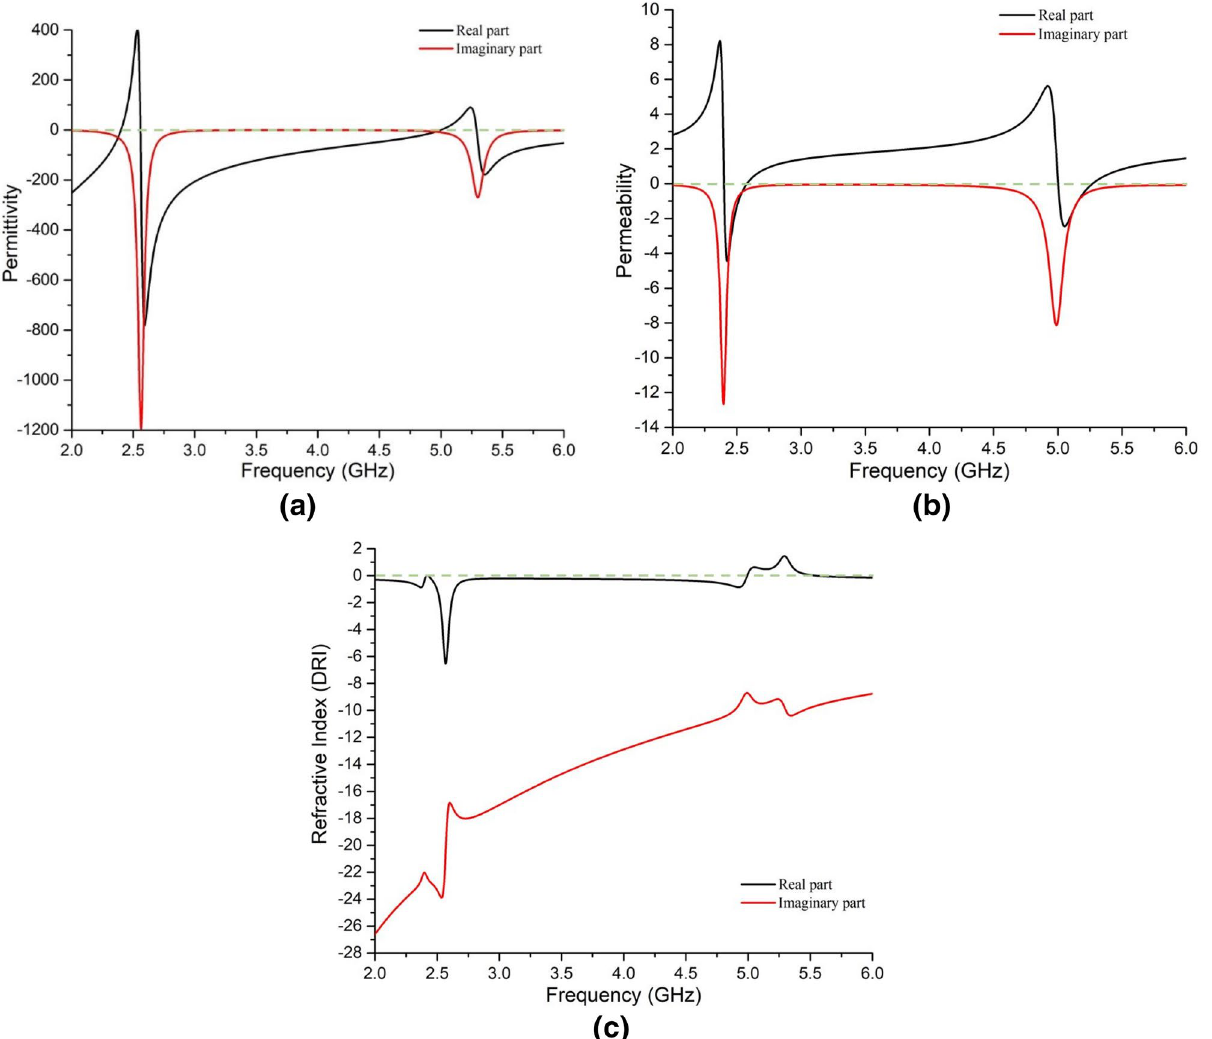
Figure 9. ( a ) Permittivity, ( b ) permeability, and ( c ) refractive index (DRI method) at operating